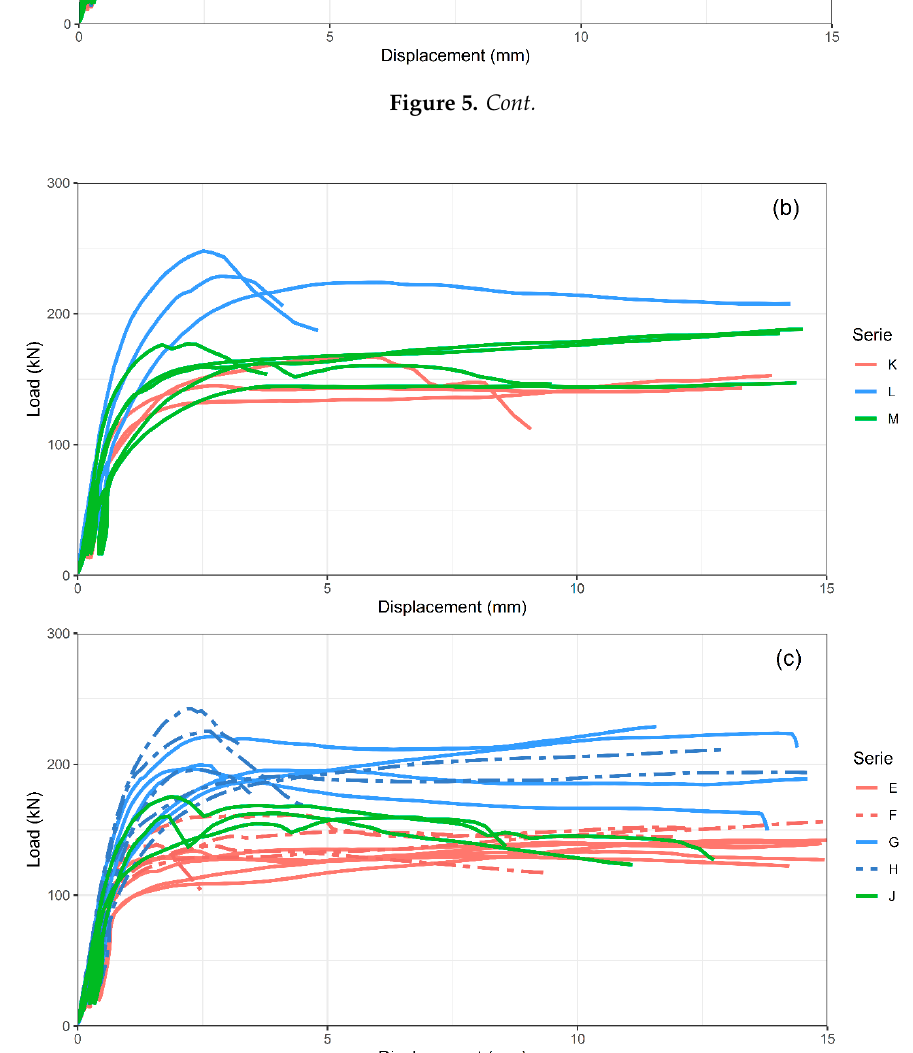
Figure 5. Load-displacement curves of specimens that have ( a ) 400 mm, ( b ) 350 mm, ( c ) 300 mm heel length, curves in red indicate 20 mm notch depth specimens, 25 mm in green, and 35 mm in blue. There were distinct gaps between the curve family with the heel length of 400 mm (Figure